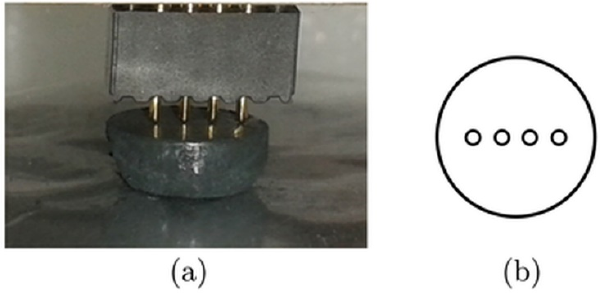
Figure 1. Four-point probe test arrangement: ( a ) Test head on the pellet photo; ( b ) Probe tips position (not to scale).